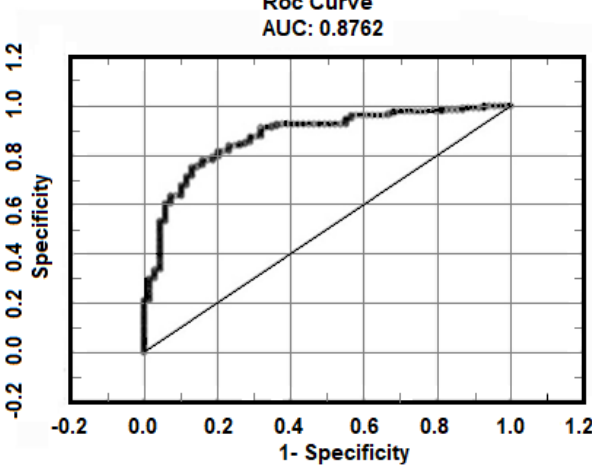
Figure 3. Receiver operating characteristic (ROC) curve for model M.